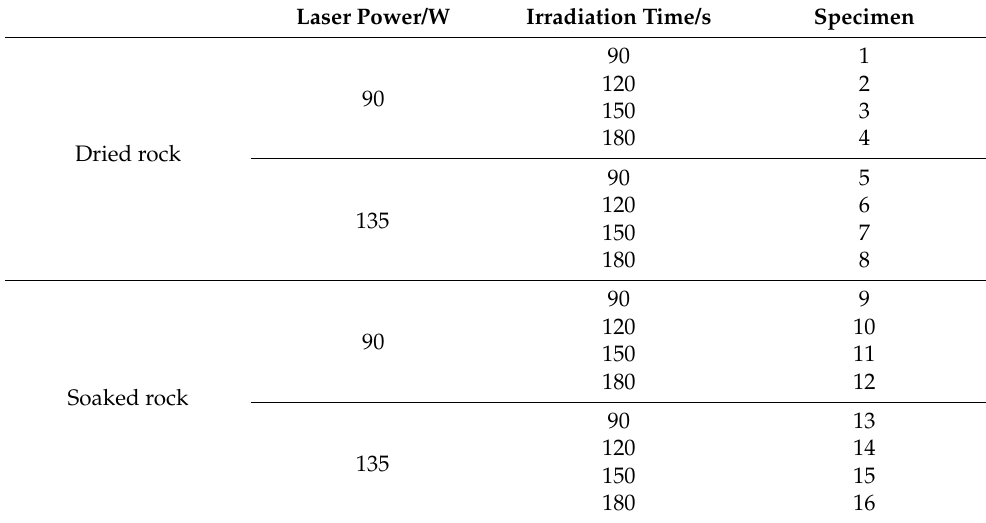
Table 2. Scheme of rock-breaking by laser irradiation. Laser Power/W